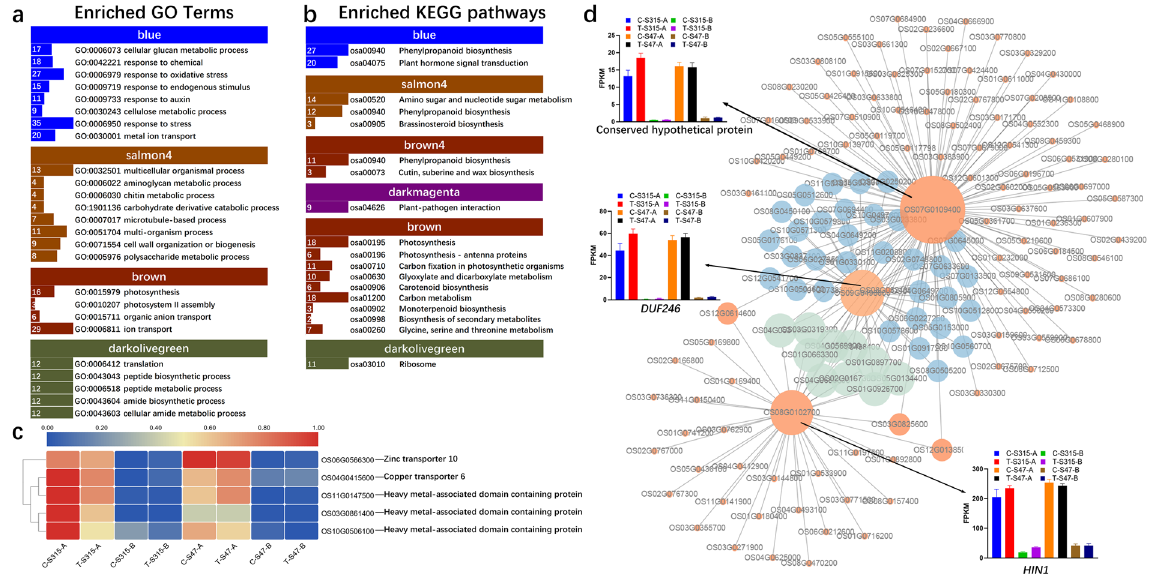
Figure 4. Enrichment of the modules associated with panicle node. The Gene Ontology biological processes (GO-BP, a ) and KEGG pathways ( b ) associated with the modules relevant to panicle node. The number ahead of the items indicates the gene number. ( c ) the expression of several genes in the node A negative module (blue). ( d ) gene interaction network and key regulator expression. The bigger the node, the greater the number of connections it has. Nodes with different colors are with different number of connections.